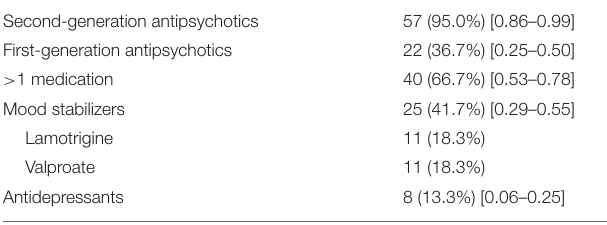
TABLE 3 | Psychotropic medications in the study group.